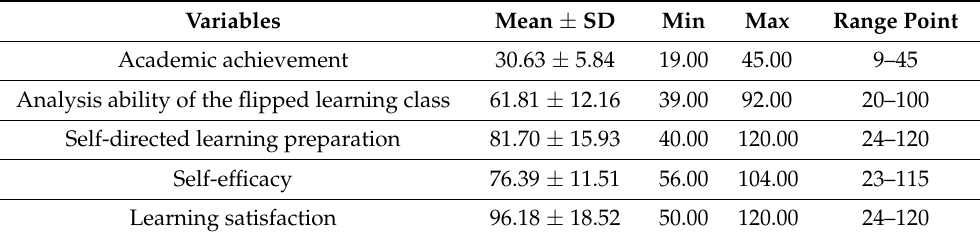
Table 2. Levels of academic achievement, analysis ability of the flipped learning class, self-directed learning preparation, self-efficacy, and learning satisfaction.